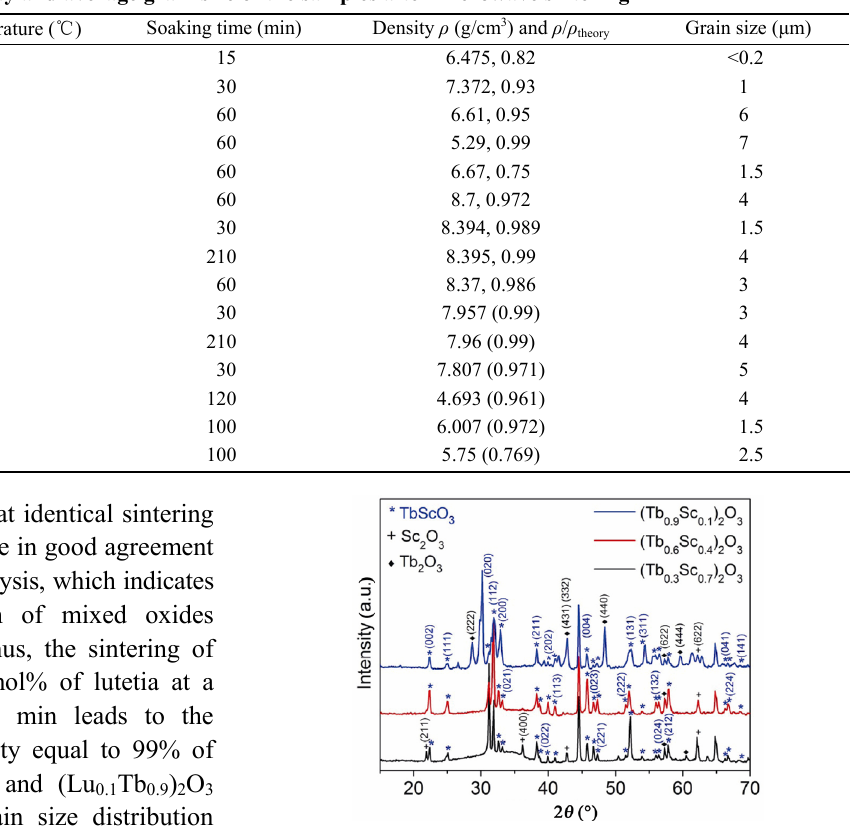
Table 2 Density and average grain size of the samples after microwave sintering